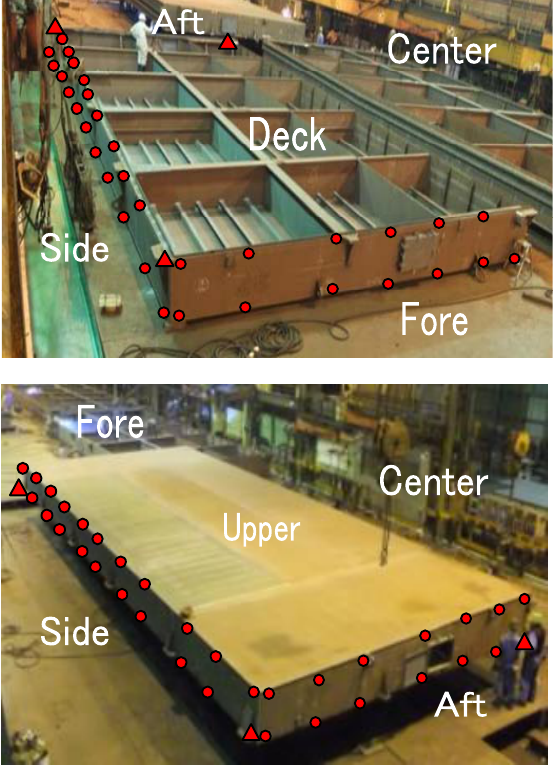
Figure 1. The shipyard and Hatch Cover ● Measurement Points ▲ Reference Points